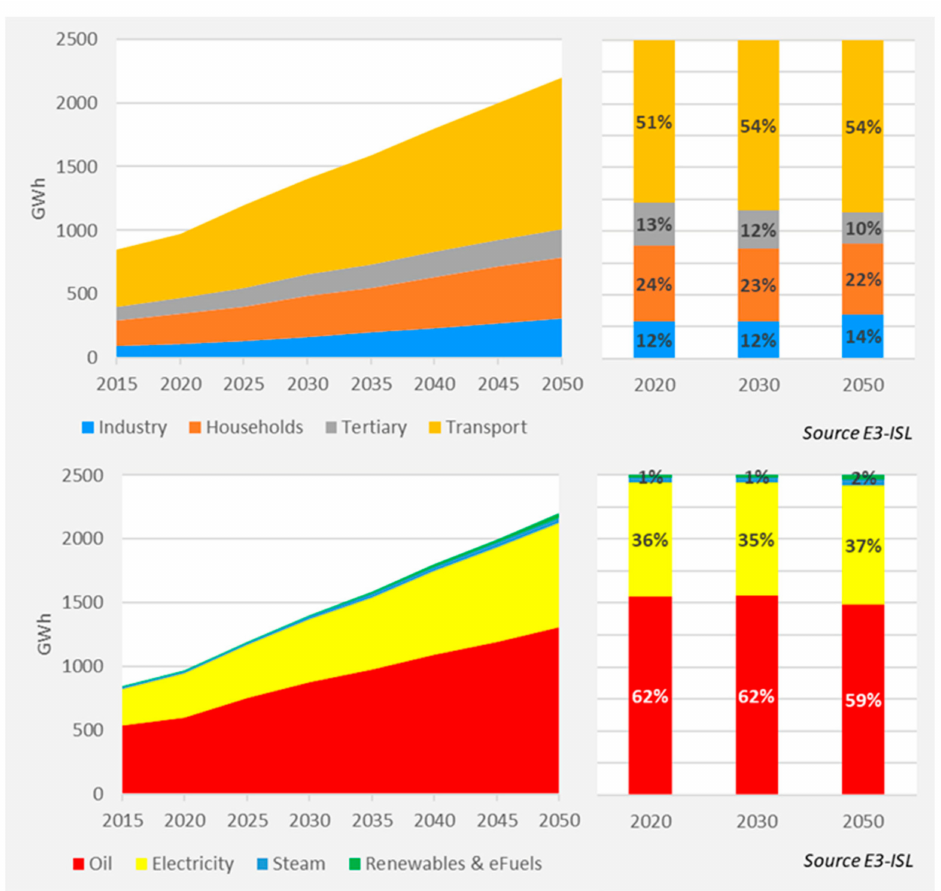
Figure 1. Baseline scenario—final energy consumption rate by main sector and fuel in 2020–2050.